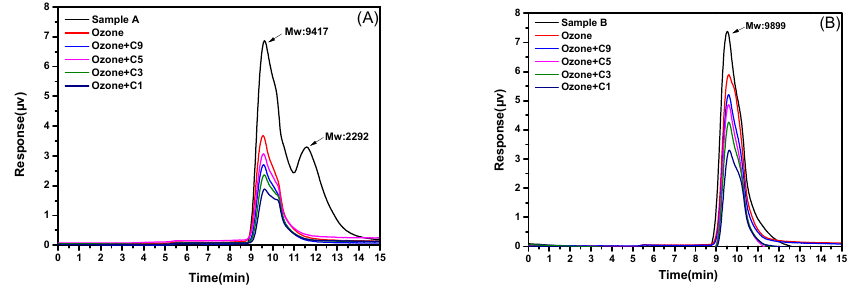
Figure 5. Molecular weight distribution of sample A ( A ) and sample B ( B ) before and after ozonation and catalytic ozonation measured at λ = 254 nm.